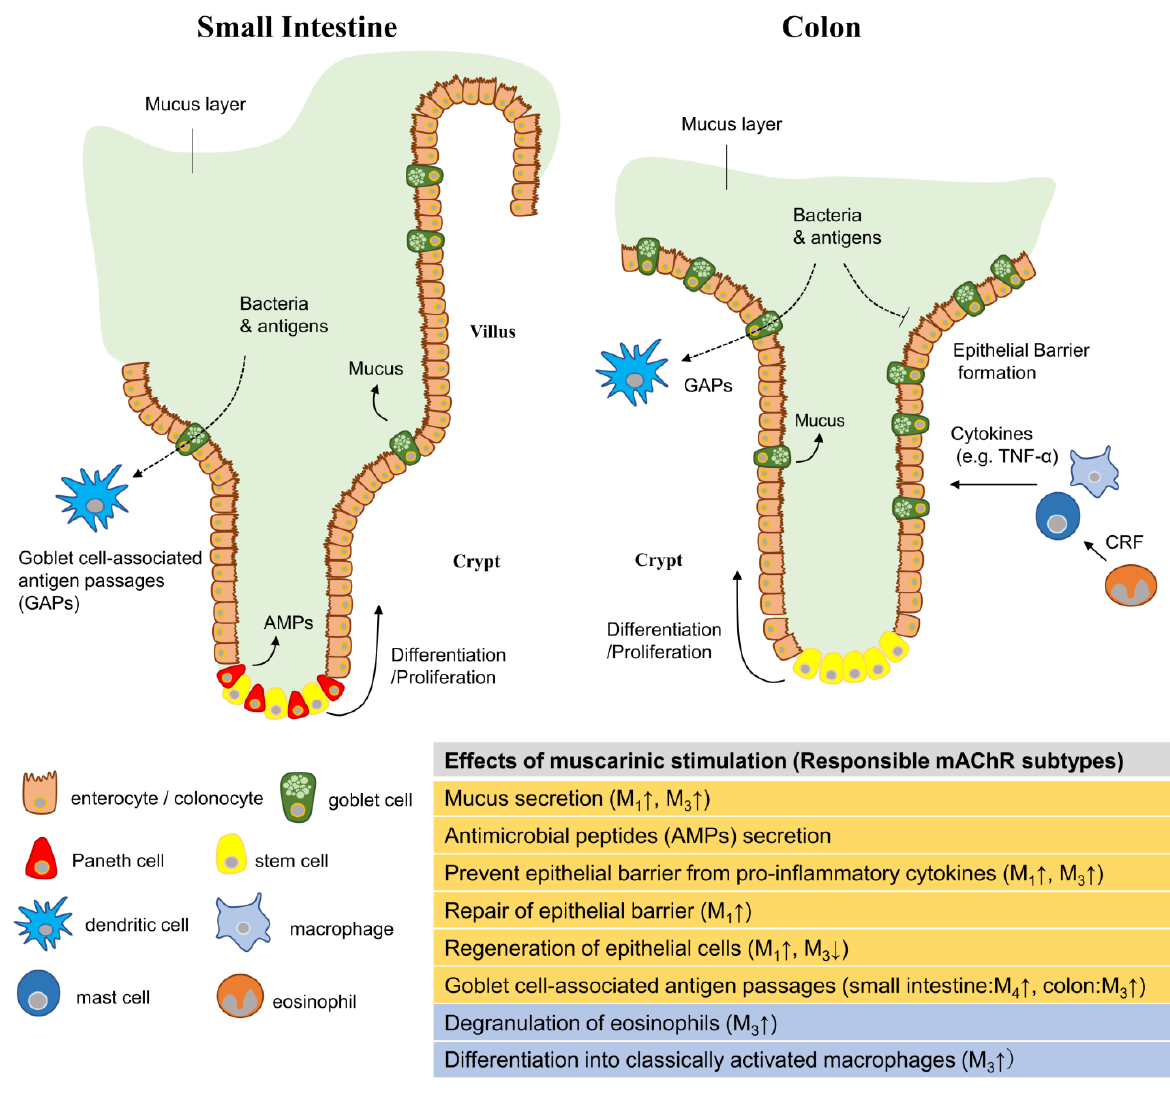
Figure 1. Mucosal defense system and muscarinic receptor action in intestinal epithelial tissue. The intestinal epithelium of the small intestine (left panel) and colon (right panel) are shown. Intestinal epithelial cells are composed of enterocytes/colonocytes, goblet cells, Paneth cells, and stem cells that are responsible for the formation of the epithelial barrier, secretion of mucus and antimicrobial peptides (AMPs), and replenishment of epithelial cells through differentiation and proliferation, respectively. Various immune cells reside or infiltrate the submucosal layer and are responsible for the immune response against invading bacteria. These cells express mAChRs that modulate the function of each cell. The table below summarizes the effects of mAChRs on each of these functions. The effects on epithelial cells are highlighted in orange while those on other cells are highlighted in blue. The up and down arrows marked to the right of the mAChR subtypes indicate that activating each subtype enhances or inhibits that response,